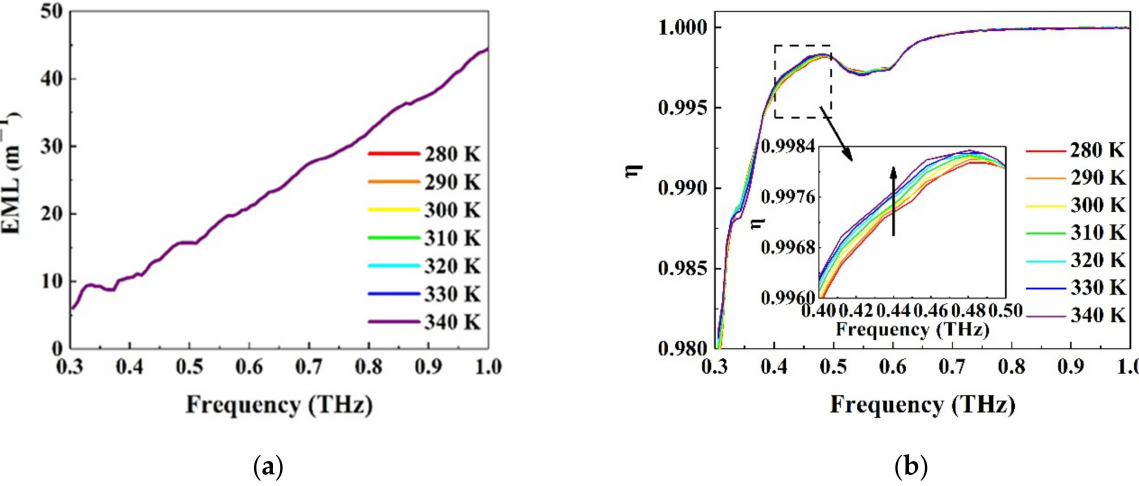
Figure 6. ( a ) EML; ( b ) core power fraction with water at different temperatures. The inset: zoomed-in core power